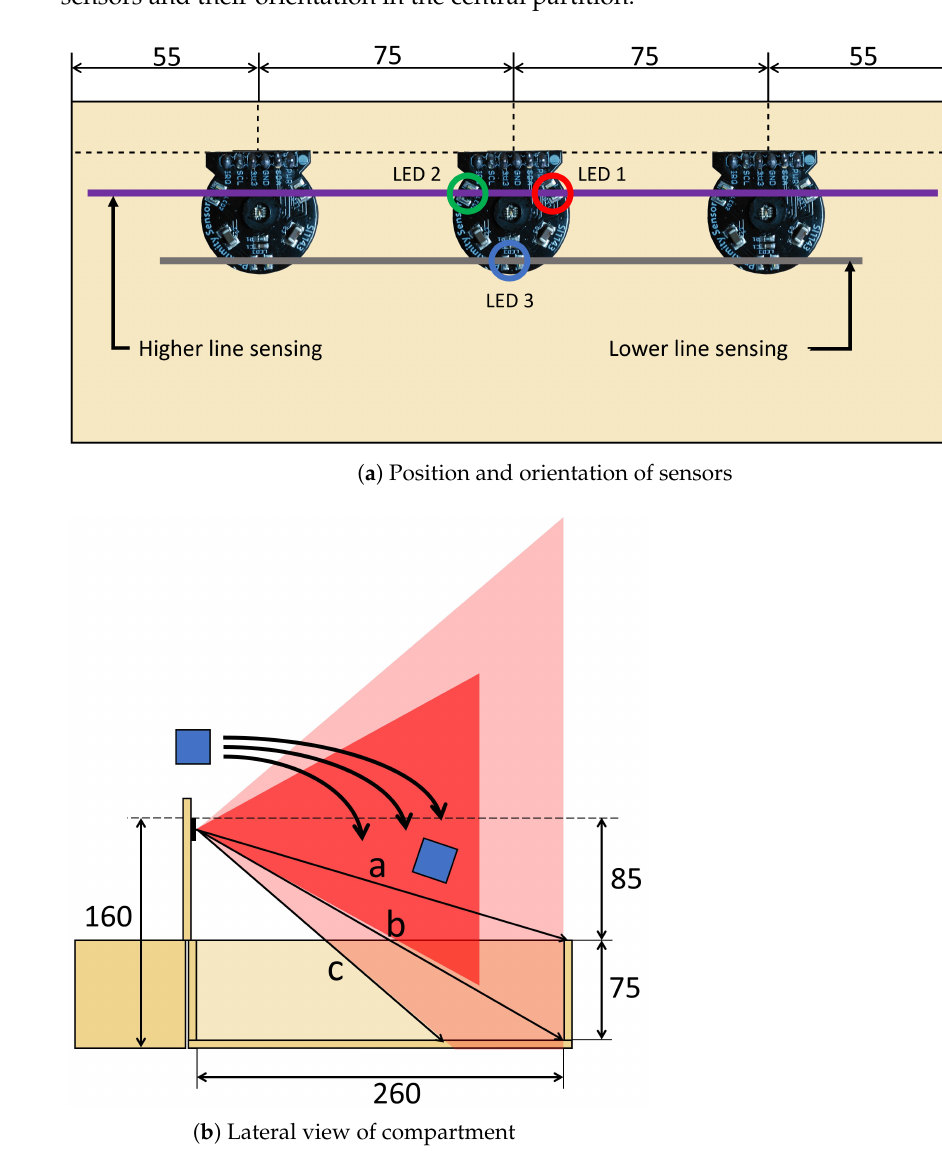
Figure 5. Layout of sensorized barrier. ( a ) Allocation of sensors, and ( b ) lateral view of sensing barrier (Distances of interest: a = 273, b = 305, c = 226). (All distances are in